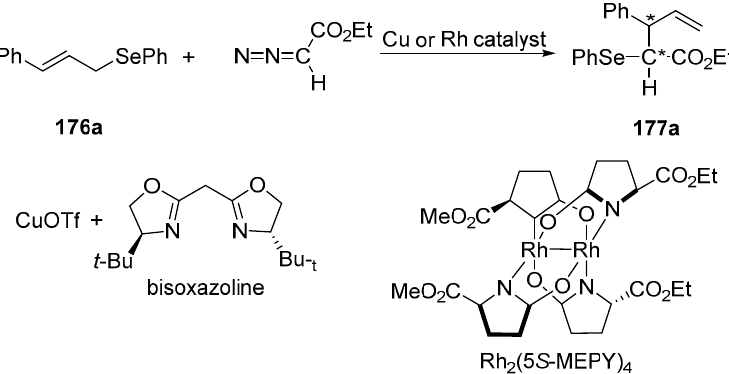
Table 14. Reaction conditions for Scheme 46: Cu: CuOTf (5 mol%) + bisoxazoline (5 mol%); ii,